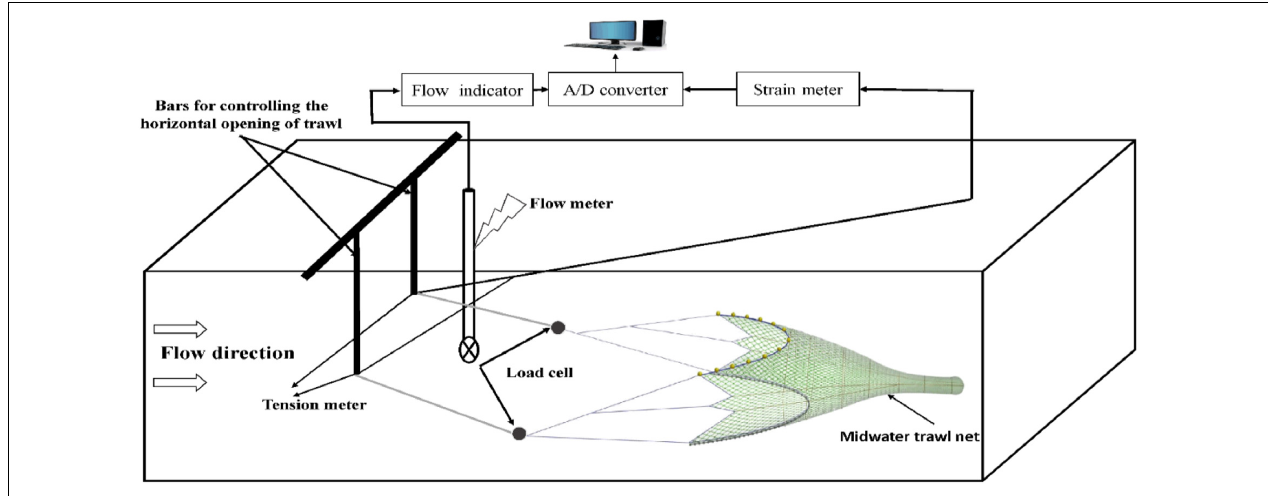
FIGURE 2 | Schematic diagram of experimental setup and apparatus for midwater trawl